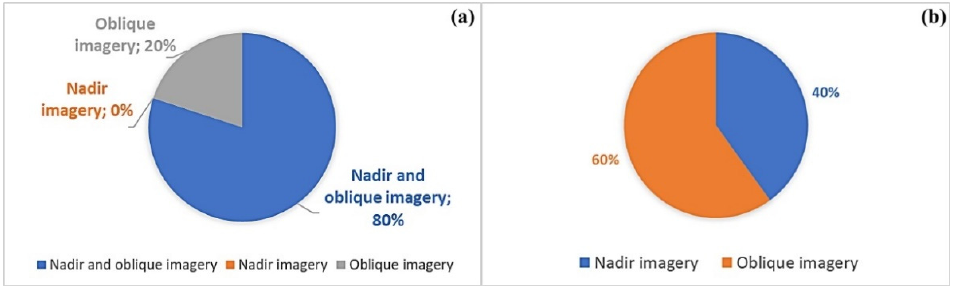
Figure 10. ( a ) Overall assessment of the accuracy of the photogrammetric products in accordance with UAV acquisition geometry using RMSE; ( b ) assessment of the accuracy of the photogrammet- ric products using RMSE between nadir- and oblique-viewing geometry.